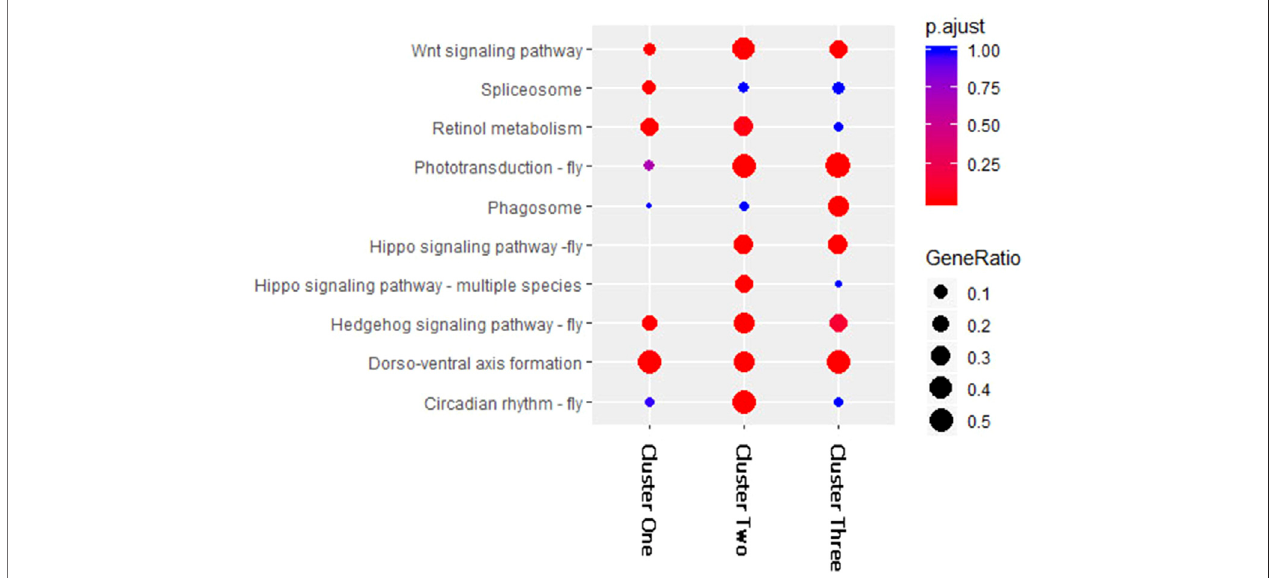
FIGURE3| KEGGenrichmentformiRNAtargetgenesofeachcluster.ThehorizontalaxisofthebubblegraphrepresentsthenumberoftargetgenesineachKEGG pathway, the vertical axis represents different channel names, the different colors of bubbles represent the FDR values, and the size of the bubbles represents the gene ratio